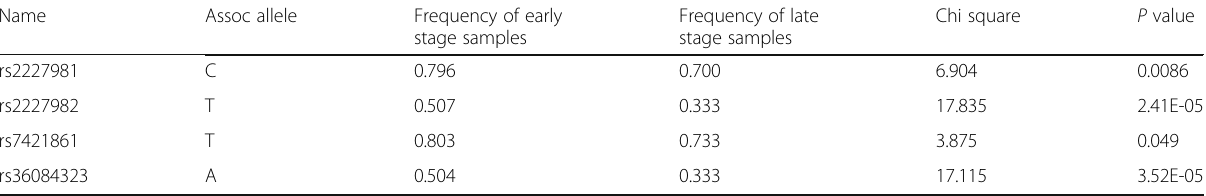
Table 3 Association of single SNPs with lung adenocarcinoma